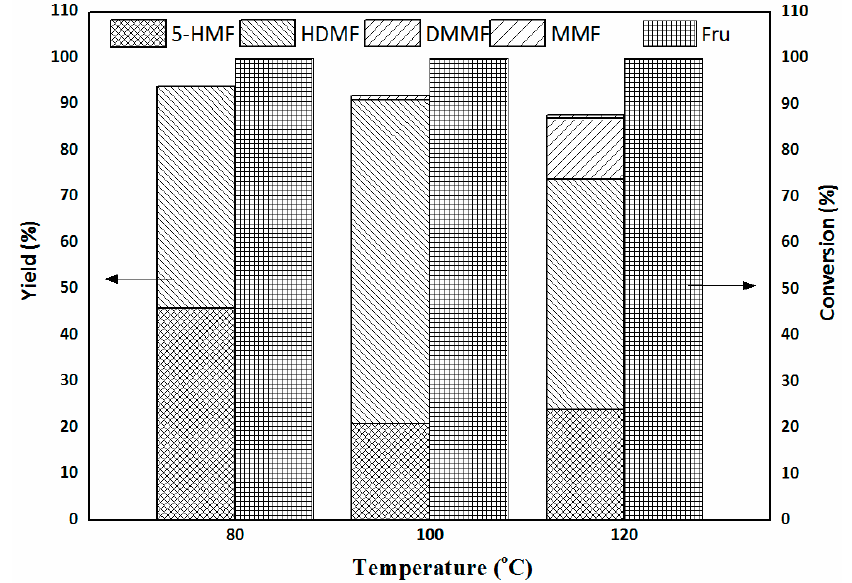
Figure 7. Effect of second-step temperature on the two-step reaction. Reaction conditions: 1.37 mmol fructose in 4.0 mL DMSO at 150 °C with 50 mg SiO 2 ‐ HNO 3 ; after 2 h, 9.3 mL methanol was added and the reaction time was extended to 3 h.